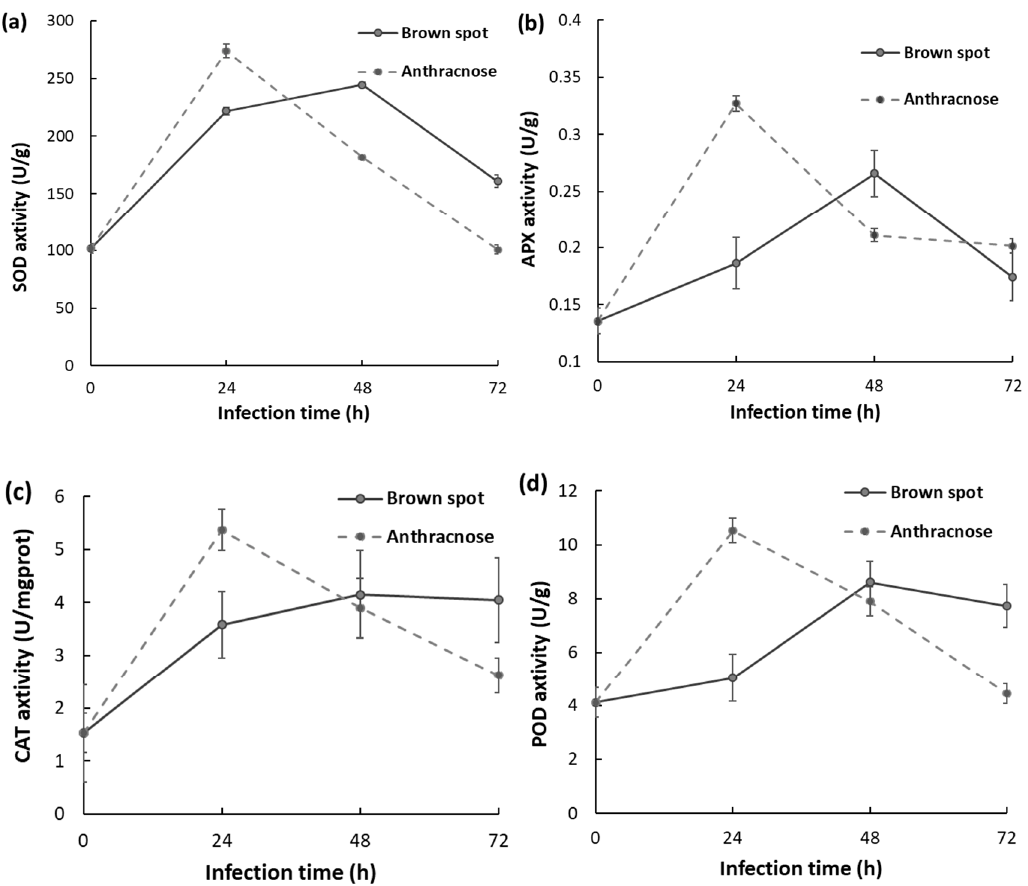
Figure 4. Effects of fungal infection on activities of SOD ( a ), APX ( b ), CAT ( c ) and POD ( d ) in cucumber leaves. Data were expressed as the mean of three replicates ± standard deviation.